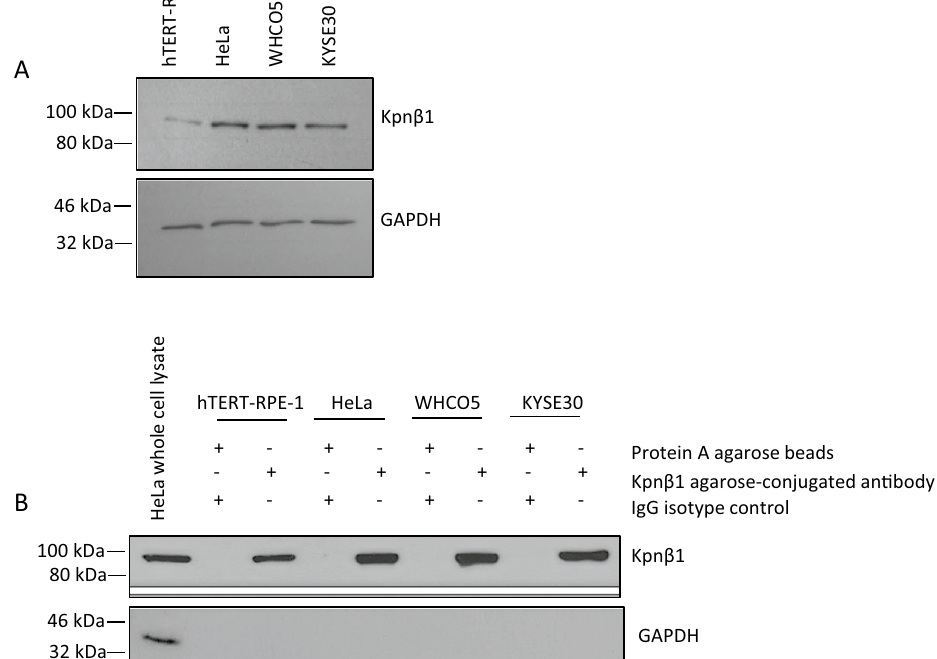
Figure 1. Immunoprecipitation of Kpnβ1. ( A ) Endogenous Kpnβ1 protein levels in non-cancer hTERT-RPE-1 cells, HeLa cervical cancer cells and WHCO5 and KYSE30 oesophageal cancer cells. GAPDH was used to control for protein loading. ( B ) Kpnβ1 was successfully immunoprecipitated using 50 µg of a Kpnβ1 agarose- conjugated antibody from hTERT-RPE-1, HeLa, WHCO5 and KYSE30 cell extracts. Kpnβ1 was not pulled down in lysates incubated with a non-specific IgG isotope control and protein A agarose beads. GAPDH was not pulled down with Kpnβ1, as